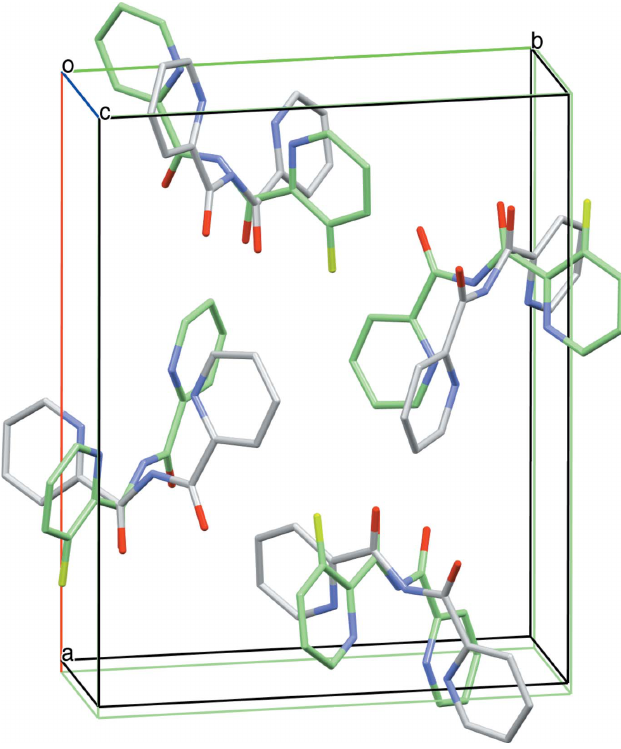
Figure 2 Unit-cell fit of the structures of 1 and 2 , showing a 90 (cid:2) rotation of the molecules of 2 (in green). Hydrogen atoms and disorder of the fluorine atoms are omitted for